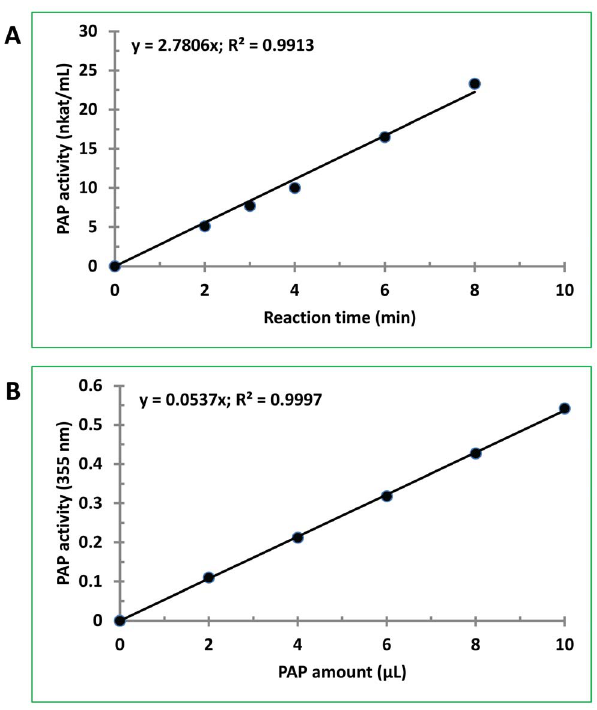
Figure 3. Linearity of PAP assays. PAP activity was assayed using aliquots of the proteins from the second S column fraction duing PAP purification. (A) PAP activity vs. reaction time. The assay was performed at 53 u C for various times with 500 m M DPA and 0.3 mM MgCl 2 . Aliquots of the enzymatic reactions were withdrawn for measurement at the indicated time points. (B) PAP activity vs. amount of enzyme. The assay was performed at 53 u C using various amounts of the PAP preparation with 500 m M DPA and 0.3 mM MgCl 2 . The data presented are the mean of 2 assays for each sample.